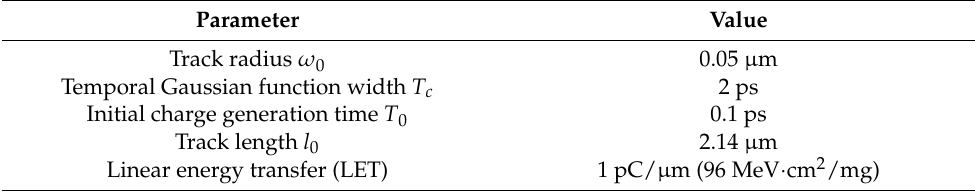
Table 2. Parameters for SEB